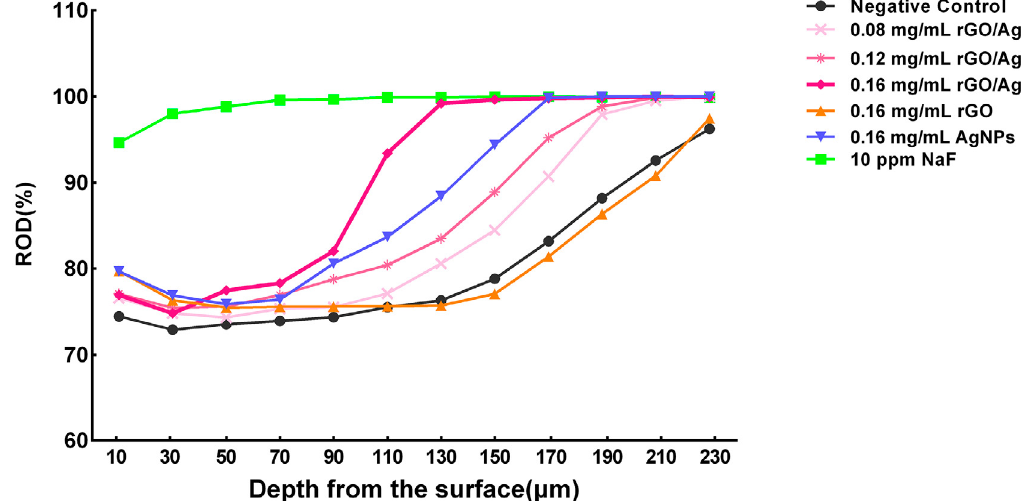
Figure 6- Profiles of each group and relative optical density (ROD) vs. depth (mm) for all the corresponding treatment